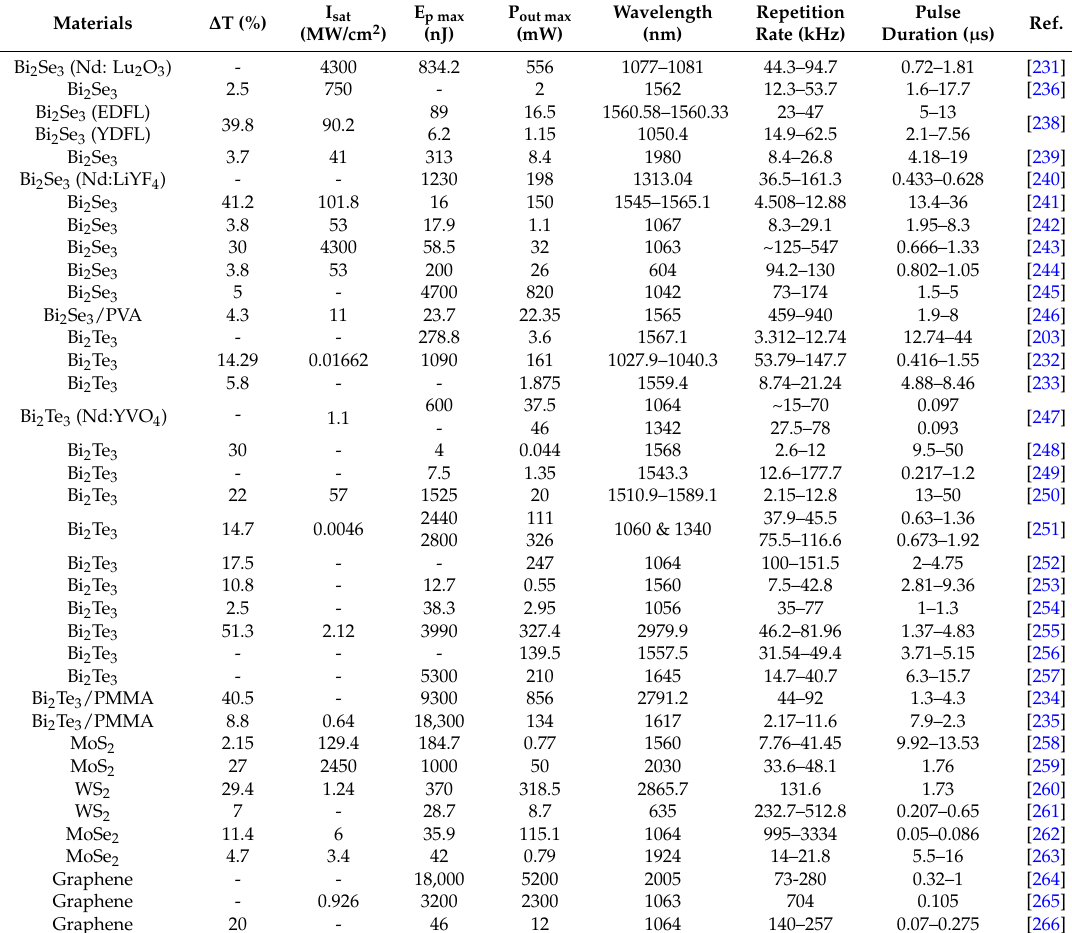
Table 7. Different Q-switched fiber lasers based on TIs and some normal